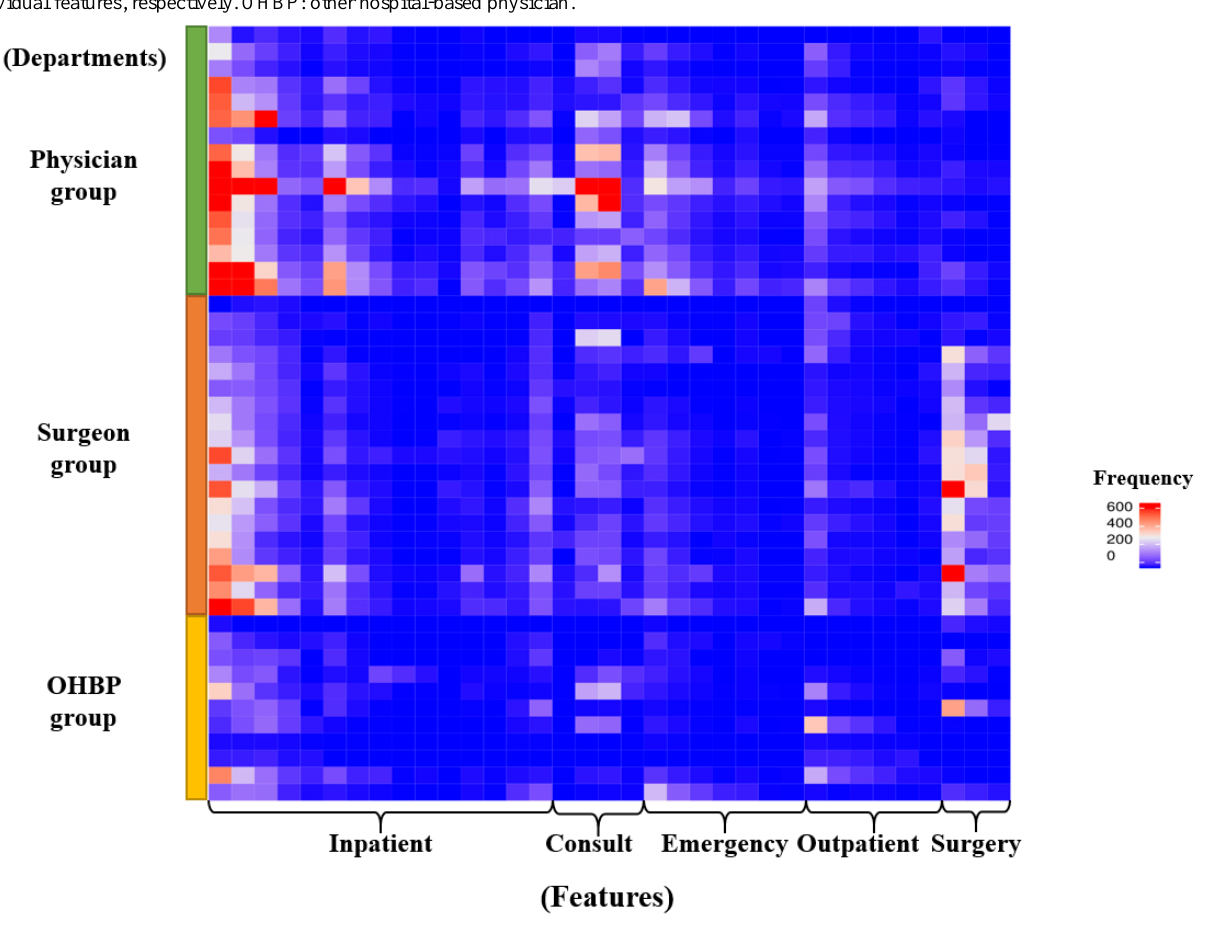
Figure 5. Heat map visualization of feature usage patterns according to users’ specialties. Rows and columns stand for specialty departments and individual features, respectively. OHBP: other hospital-based